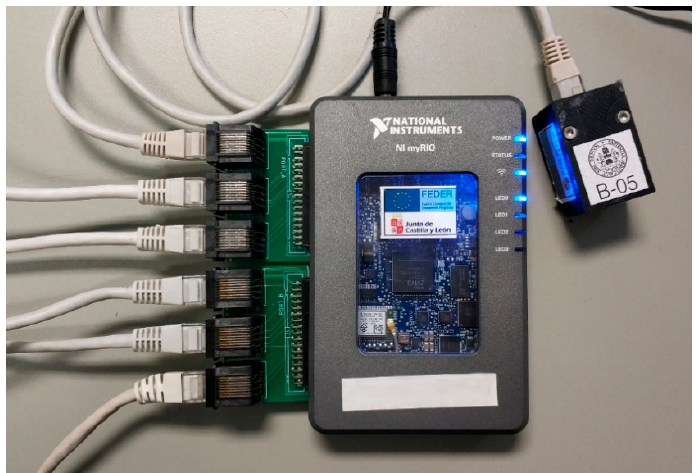
Figure 3. MyRIO device with two adapter boards and an accelerometer.